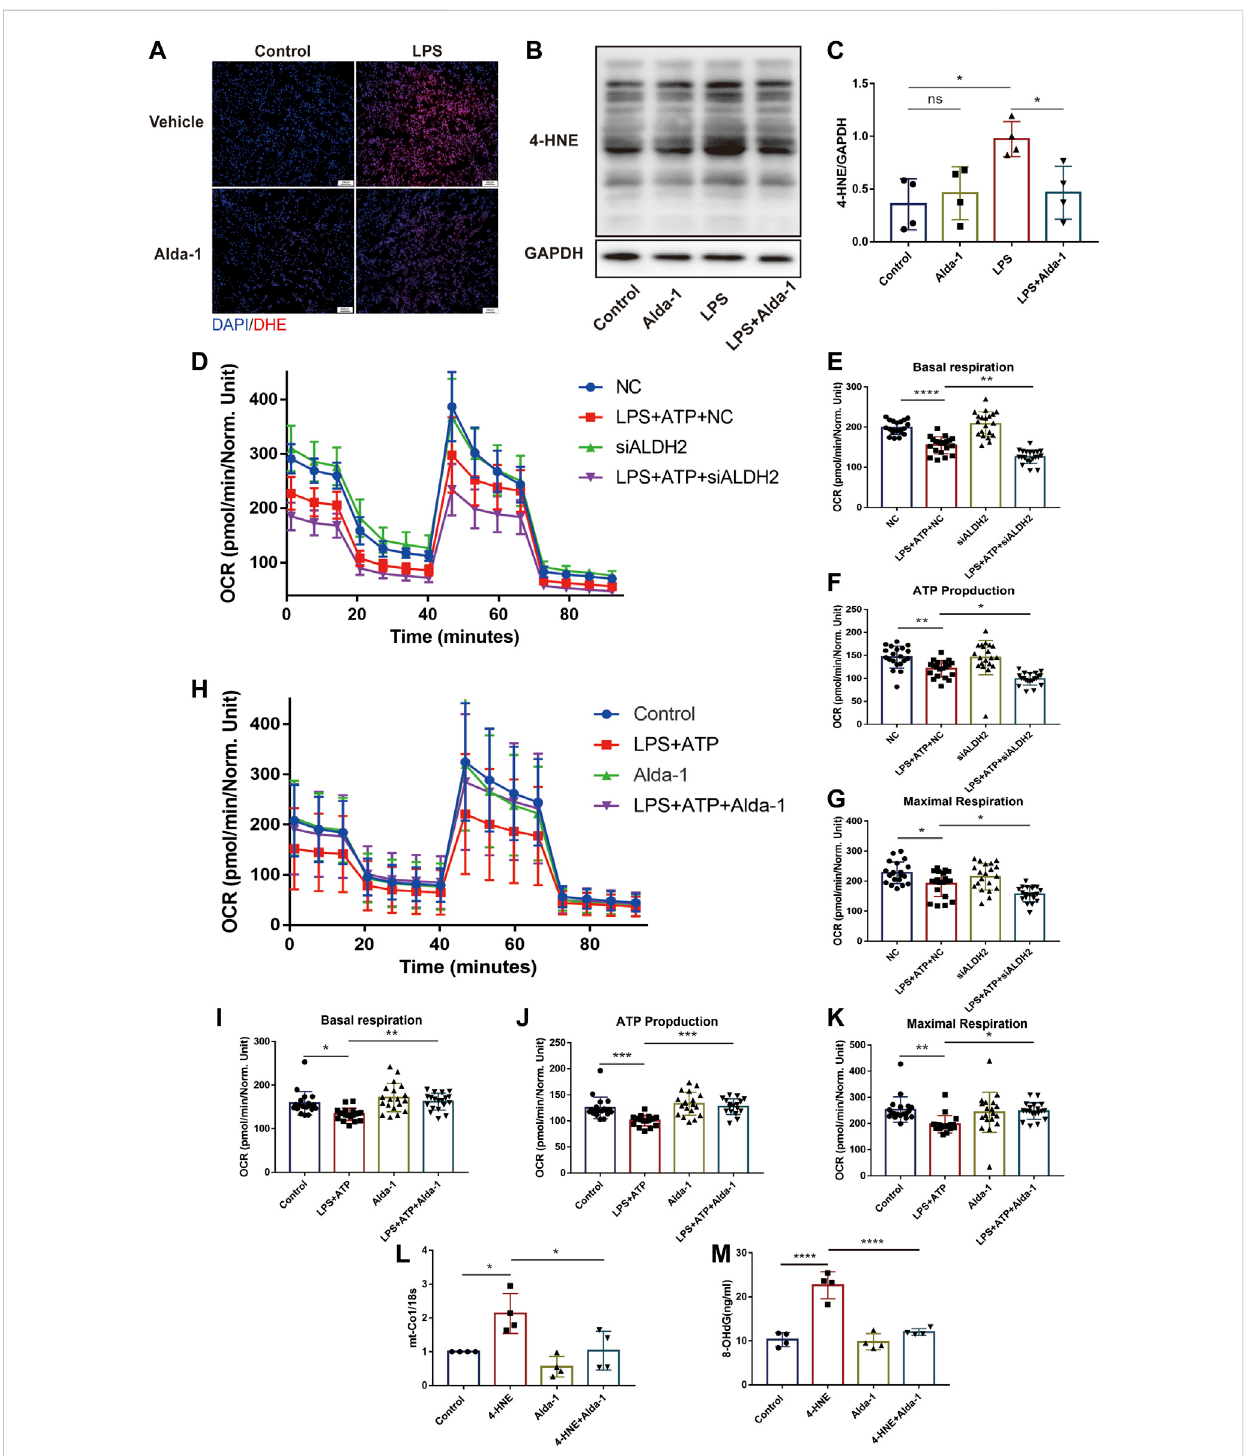
FIGURE 5 ALDH2 suppresses myocardial toxic aldehyde accumulation, oxidative stress, and improves mitochondrial respiratory function. (A) Representative dihydroethidium (DHE) staining images in cardiac tissue, scale bar: 200 μ m. (B,C) Representative immunoblots and quanti fi cation of 4-HNE-protein adducts in cardiac tissue, the LPS stimulated mice were pre-treated with or without Alda-1, n = 4 per group. (D – K) Mitochondrial respiration measurementsofOCRinH9C2cellstreatedwith Aldh2 siRNAornegativecontrol(NC)orAlda-1,quanti fi cationofbasalrespiration,ATPproduction, andmaximalrespiration. (L,M) Thelevels oftotalmtDNAor ox-mtDNAin4-HNE-stimulated orcontrol H9C2cellspre-incubatedwith orwithout Alda-1, n = 4 per group. Mean ± SEM. **** p < 0.0001; *** p < 0.001; ** p < 0.01; * p < 0.05; ns = not signi fi